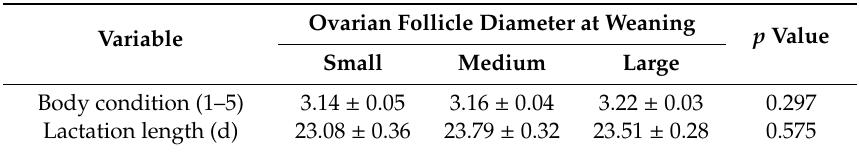
Table 2. Body condition and lactation length (mean ± SEM) at weaning in the sows showing small (0.20–0.30 cm), medium (0.31–0.39 cm), and large (0.40–1.00 cm) ovarian follicular diameter at